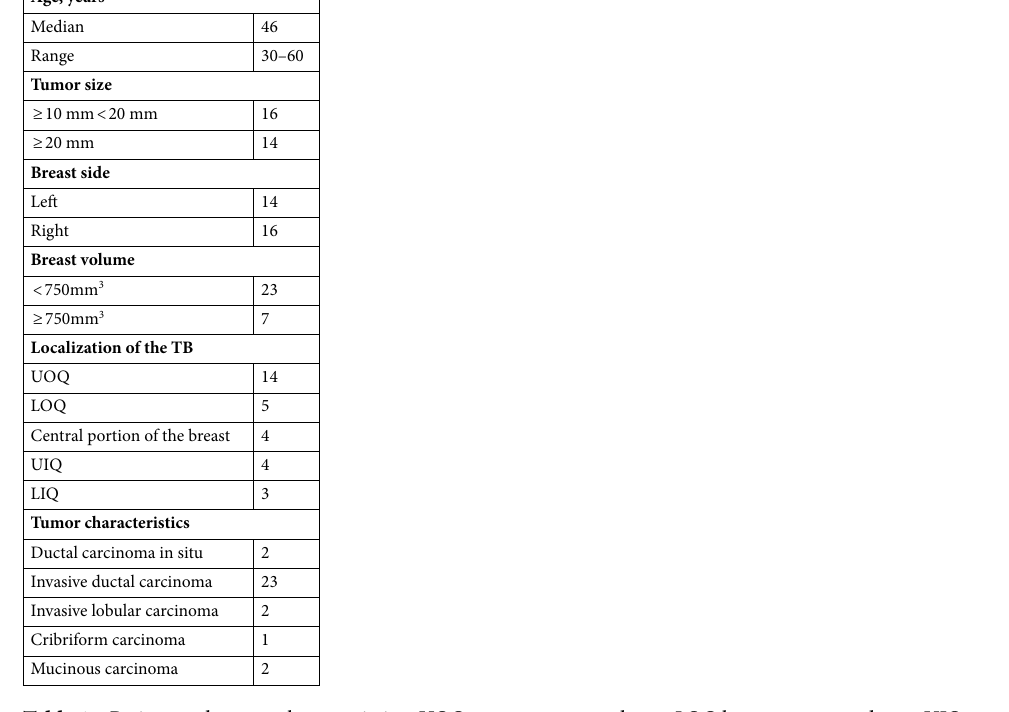
Table 1. Patient and tumor characteristics. UOQ upper outer quadrant, LOQ lower outer quadrant, UIQ upper inner quadrant, LIQ lower inner